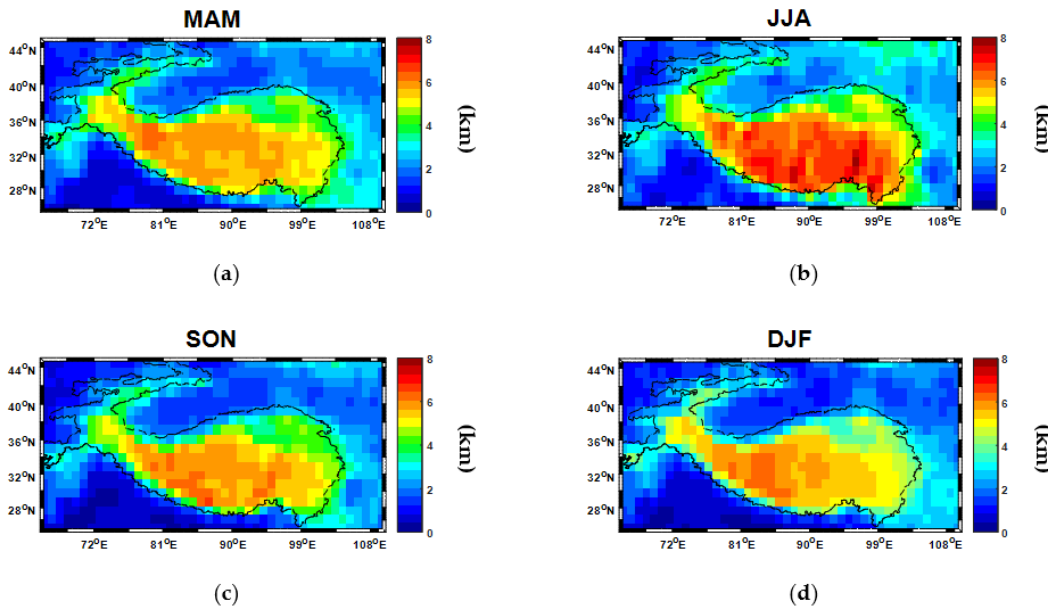
Figure 5. Seasonal maps of the lowest aerosol layer base over the TP: ( a ) spring, ( b ) summer, ( c ) fall, and ( d ) winter over the eight-year data period from January 2007 to December 2014 (The AOD is at 532 nm and the map is gridded at 1°).